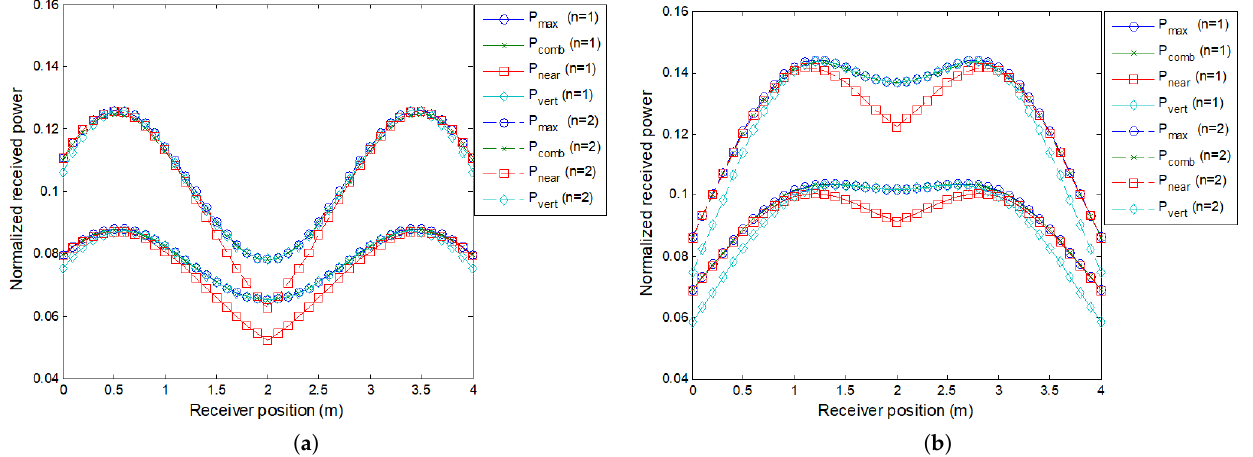
Figure 7. Received power from two lamps for different orientations of the receiver when it moves along the x-direction: ( a ) Results for a distance between lamps of 3 m. ( b ) Results for a distance between lamps of 2